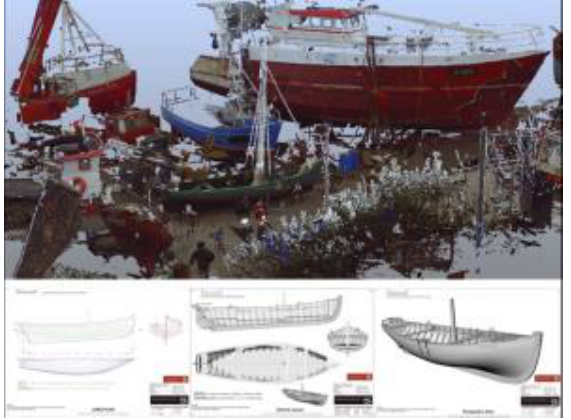
Figure 3. Laser Scanning - Traditional Boats of Ireland ©Pat